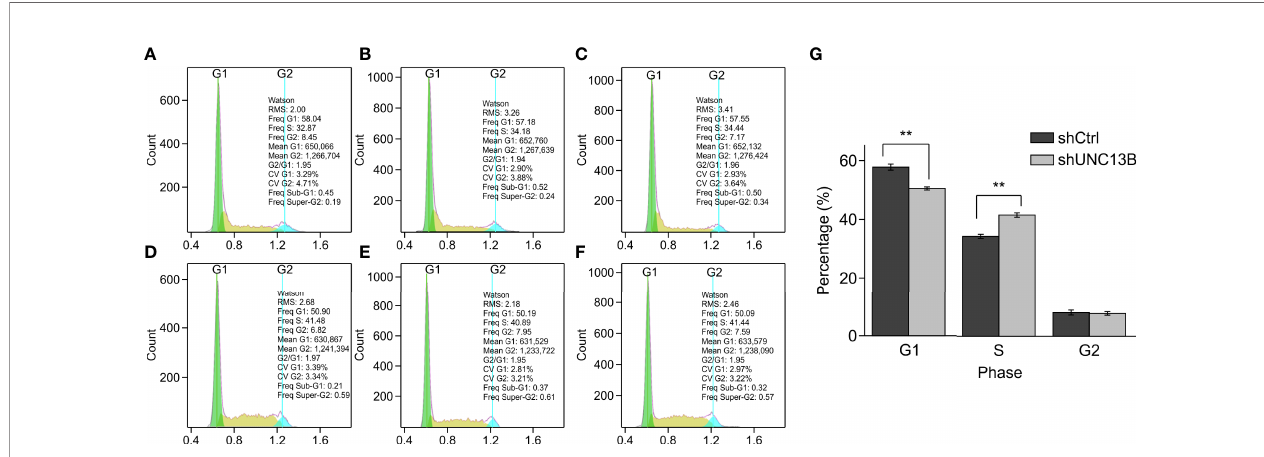
FIGURE 4 | Cell cycle analysis by fl uorescence-activated cell sorting (FACS) of arsenic trioxide (ATO)-resistant K-562 cells after UNC13B knockdown. (A – C) FACS analysis of the shCtrl group. (D – F) FACS analysis of the shUNC13B group. (G) Quanti fi cation of the G1, S, and G2 phases of the shCtrl and shUNC13B groups. ** p <